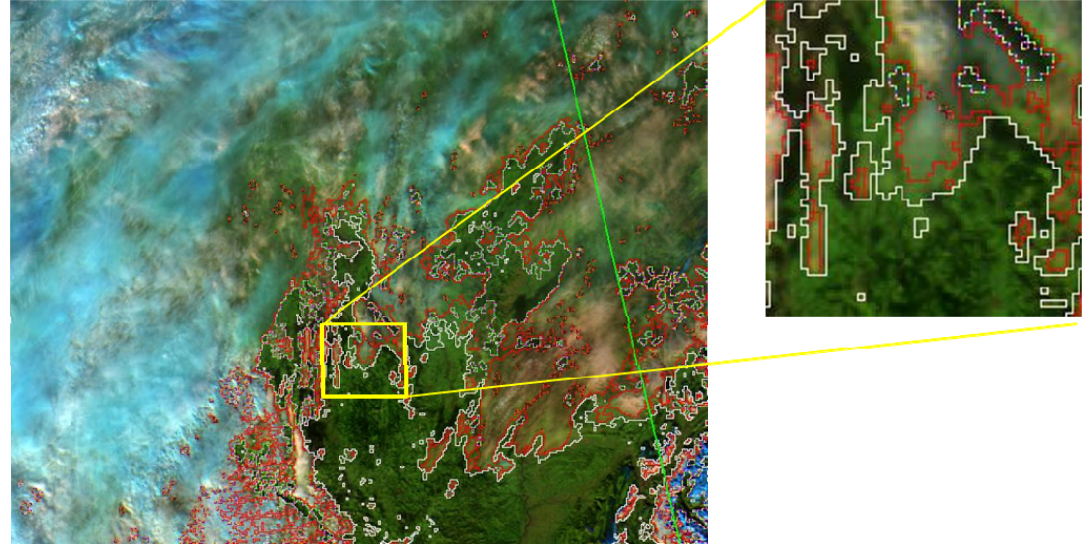
Figure 7. Comparison of cloud masks before (in white) and after (in red) the threshold correction. The green line corresponds to CloudSat tracks.